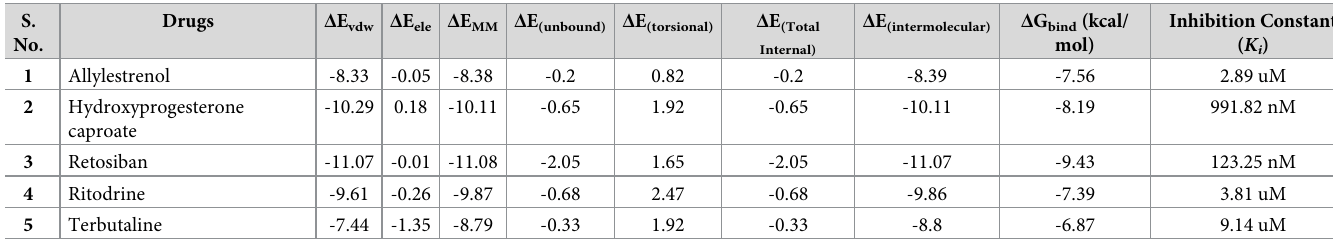
Table 9. Docking-guided molecular mechanics and estimation of ligand binding energies of PTB-related drugs with CNN1 isoform 2. S. No.